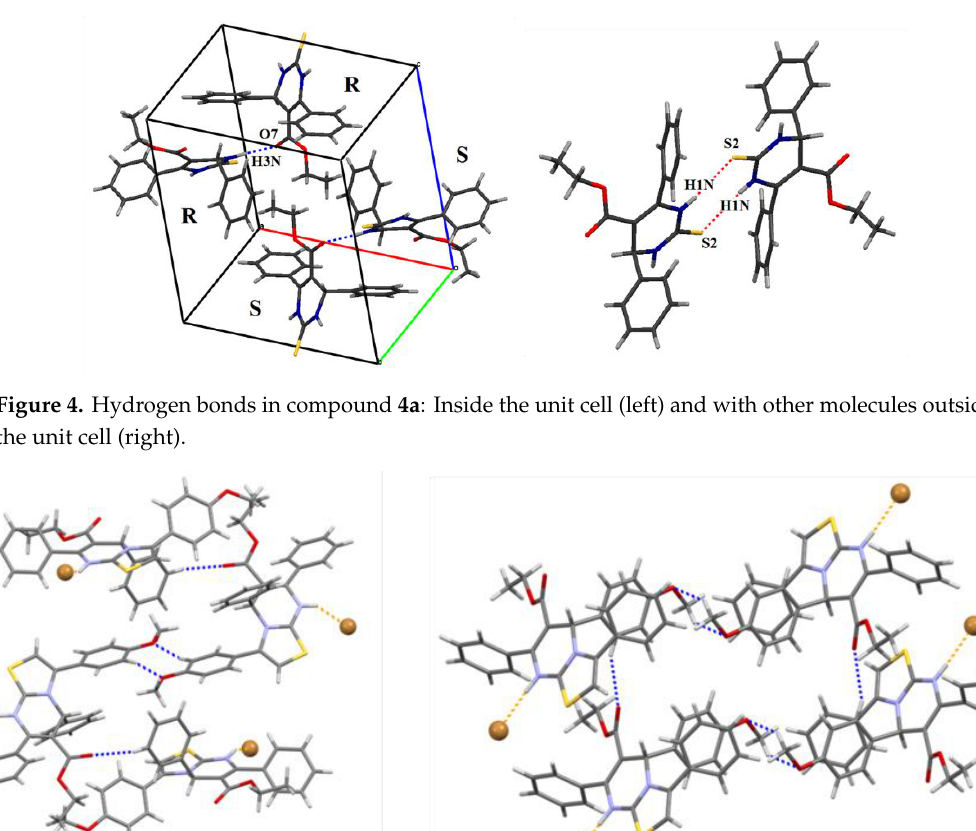
Figure 3. ( a ) 3D Hirshfeld surfaces mapped with d norm ; red colored regions show shorter contacts; ( b ) histograms showing the percentage contributions of the various types of interactions predicted for compounds 4a , 7b , and 7d.